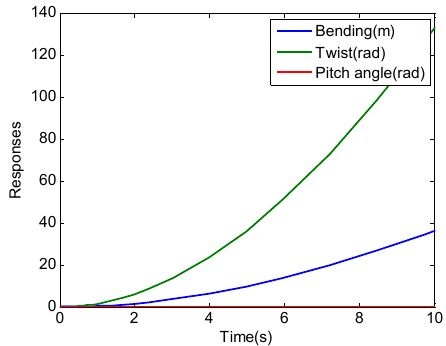
Figure 2. The uncontrolled displacements.